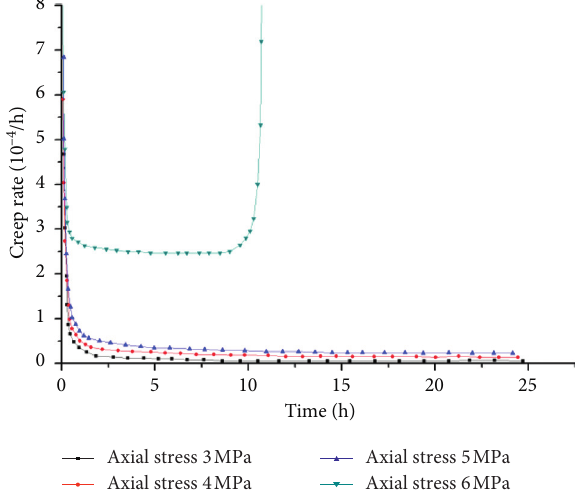
Figure 16: The creep rate under different axial pressures and 1.0 MPa water